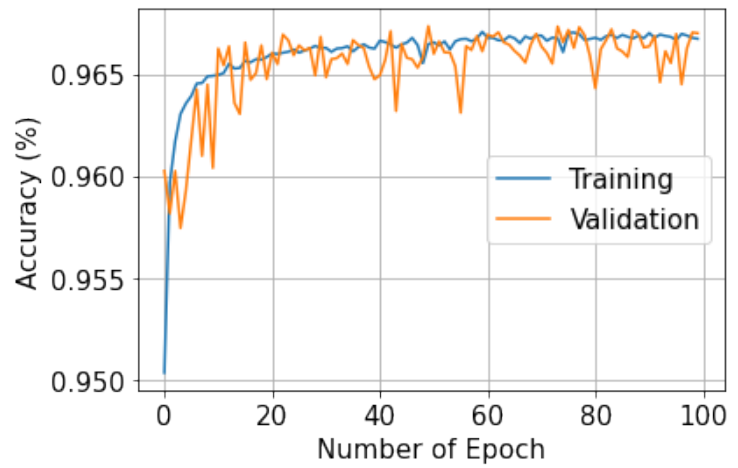
Figure 3. The graph illustrates the accuracy of the training and validation of the proposed model over a period of 100 epochs.